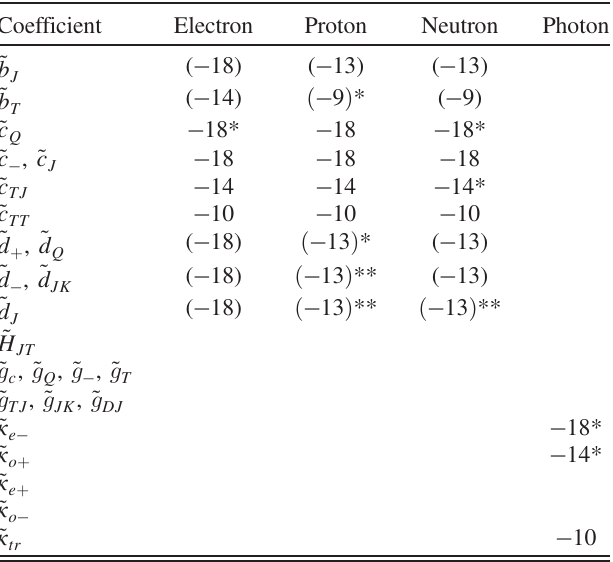
TABLE V. Potential order-of-magnitude sensitivities from phonon-sector experiments, assuming a δν = ν ¼ 10 − 19 resolution. Tabulated is log 10 of the expected bound in GeV. Limits in parentheses assume a spin-polarized solid. For entries marked with an asterkisk (*), the sensitivity of phonon-sector experi- ments is equal to or better than the maximal sensitivity listed in the 2015 edition of Ref. [34] for at least one component. For entries highlighted by two asterisks (**), no limit is available in Ref. [34] on at least one